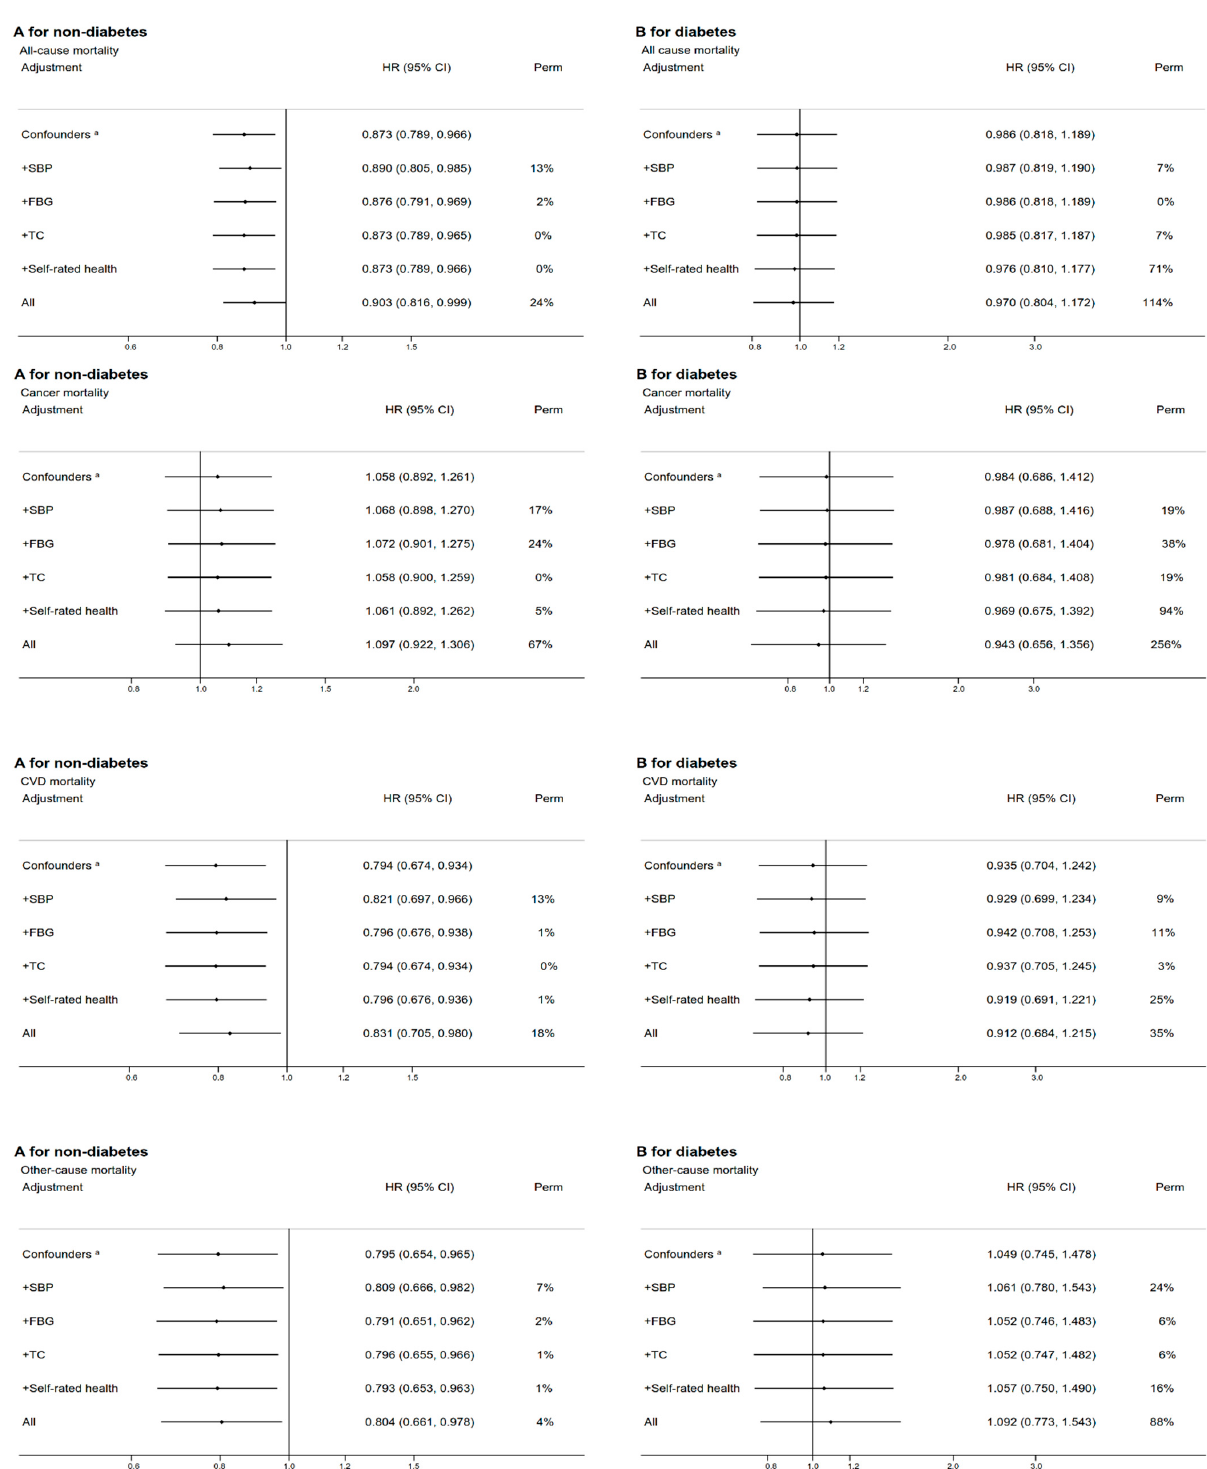
Figure 2. The associations between the vegetable-based LCD score (Q4 versus Q1) and mortality, and the proportions of the associations attributable to systolic blood pressure, fasting plasma-glu- cose, total cholesterol, and self-rated health ( A : participants without diabetes, B : participants with diabetes).